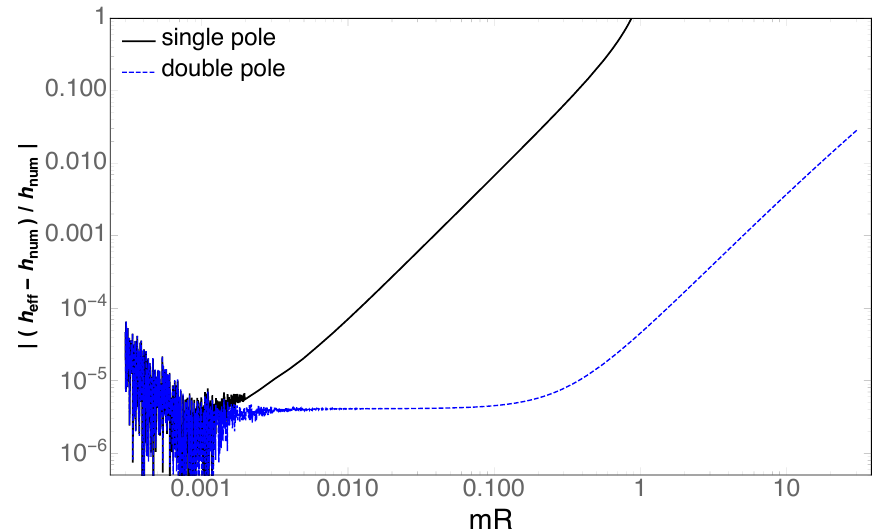
Figure 3 . A plot of the relative error made when computing (cid:14)!= j (0) j 2 for nonzero C=A using two analytic approximations single pole (black solid) and double-pole (blue dashed) to the right-hand side of eq. (4.2) as described in the main text. The plot’s horizontal axis is mR , where m is the mass of the orbiting fermion and R is the size of the source. For plotting purposes we use Z(cid:11) = 1 = 137 and compute the shifts to the parity-even j = 1 state with n = 2 assuming the source to be a shell 2 of positive charge with radius R